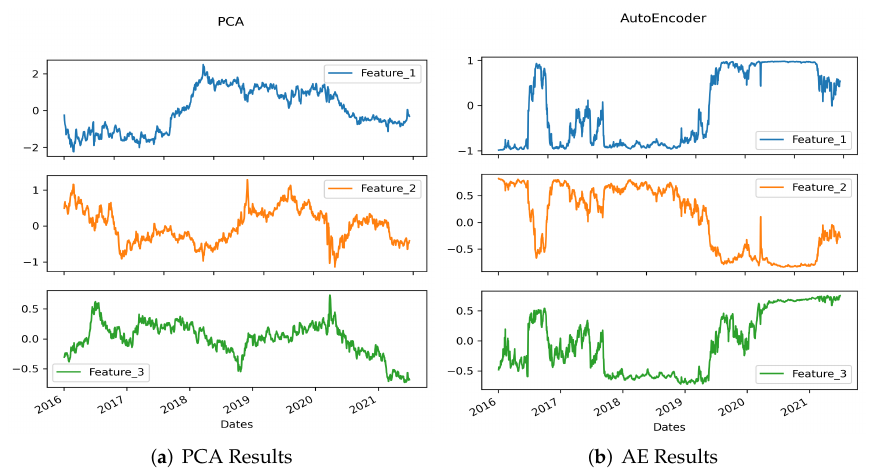
Figure 16. Comparison of the results of PCA and AE for the UK data.